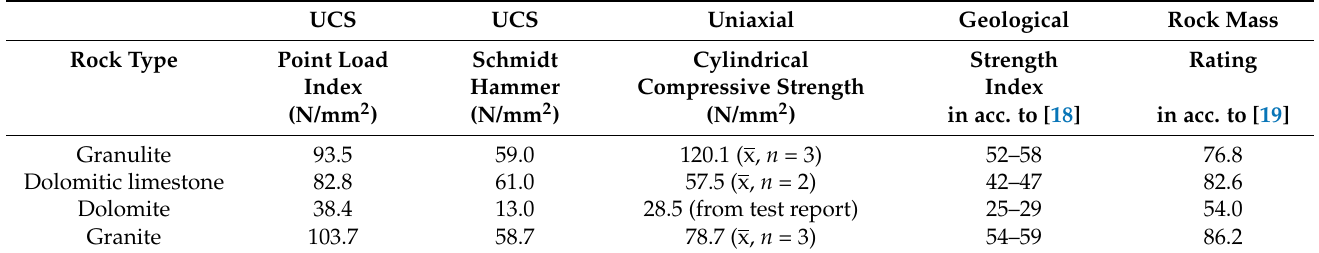
Table 2. Overview–geological